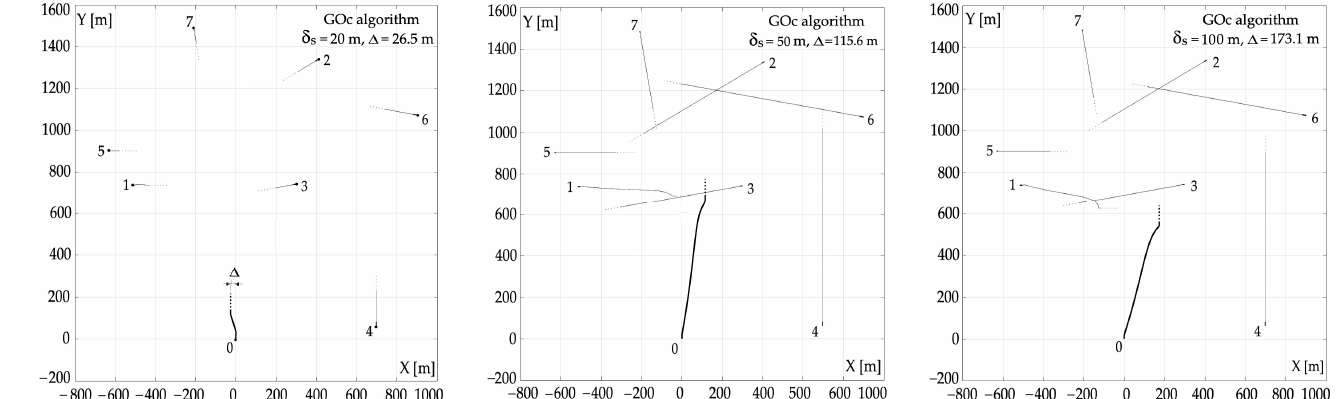
seven other non-cooperating autonomous vehicles for three safe passing distance values.